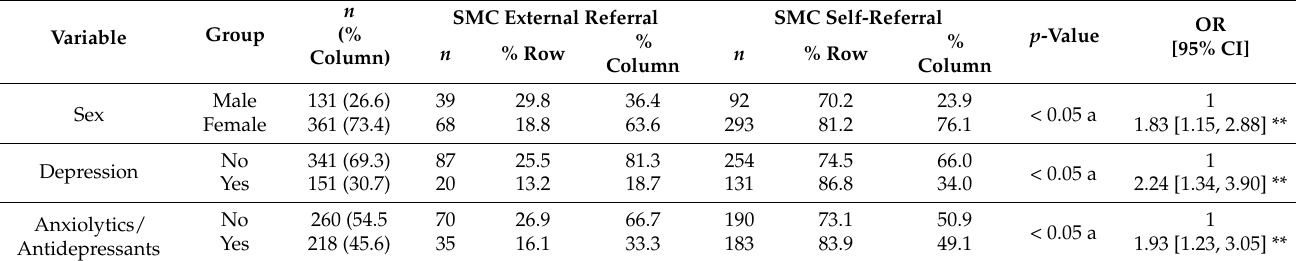
Table 3. The association between SMC and the patient profile variables.